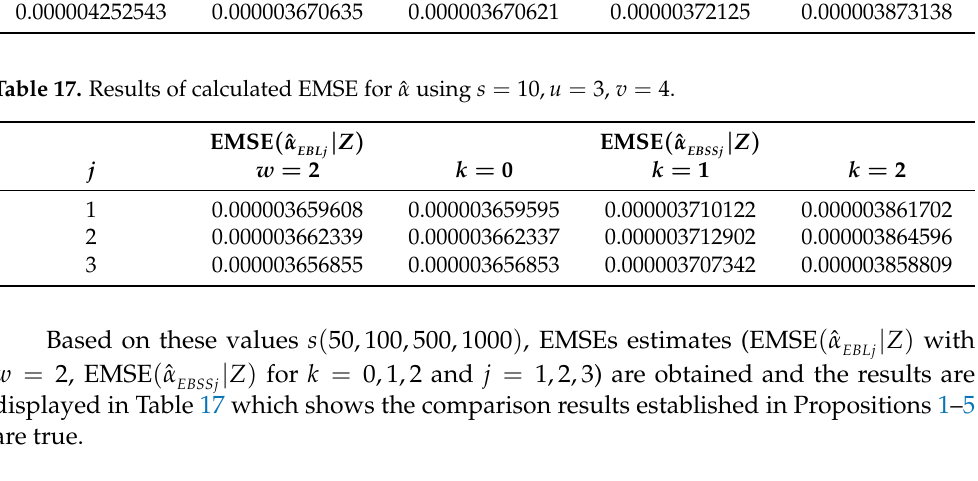
Table 18. Results of calculated EMSE of ˆ α for different s with u = 3 and v = 4 using data from Table